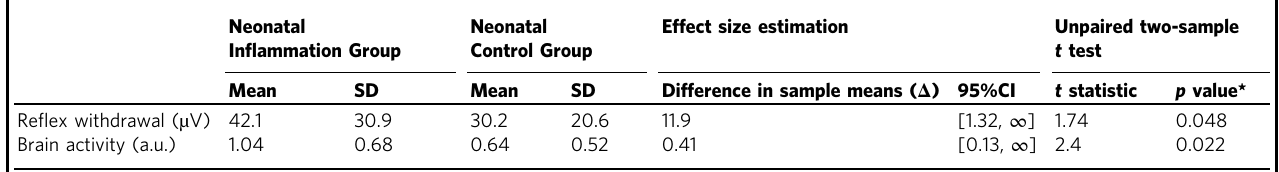
Table 2 Noxious-evoked spinal re fl ex withdrawal and brain activity in the Neonatal In fl ammation Group and Neonatal Control